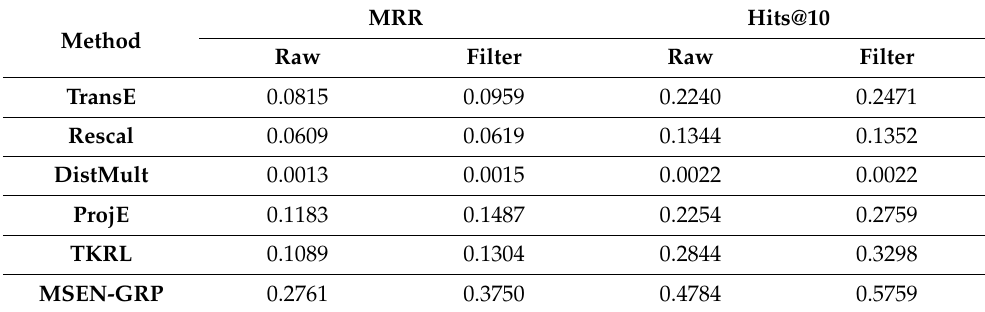
Table 7. Comparison of experimental results.